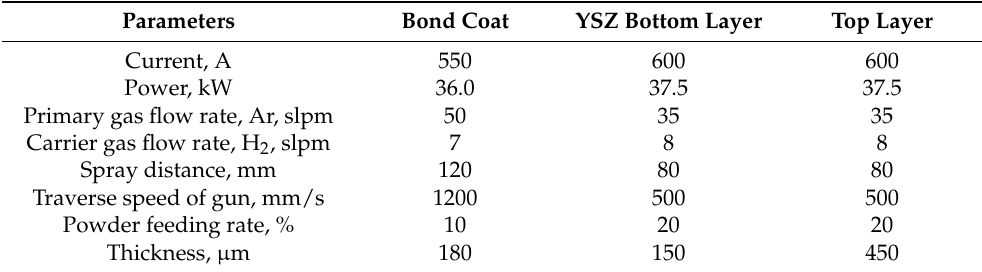
Table 1. Plasma-spraying parameters for TBCs deposition.